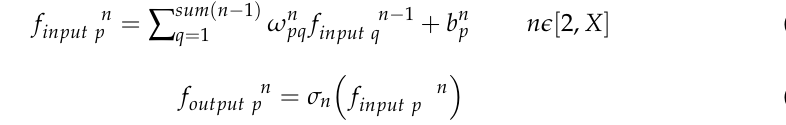
Table 2. Settings of the weights, biases and activation function.